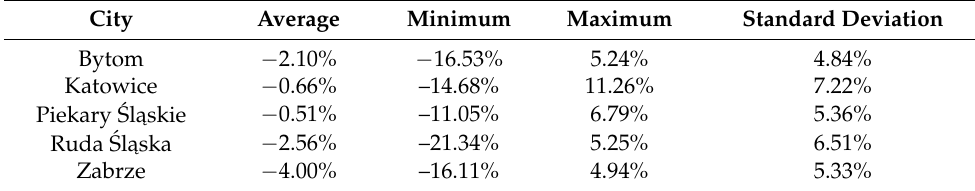
Figure 1. Ratio of the budget deficit/surplus to the annual budget revenues for 2003–2020 (in %) for the city of Bytom. Source: own elaboration. Table 2. Statistics for deficits/surpluses of the examined